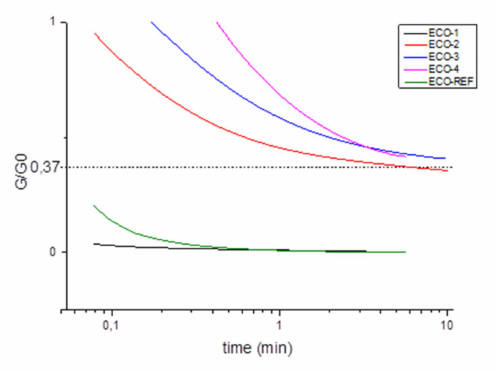
Figure 2. Dynamic behavior of each formulation at 200 ◦